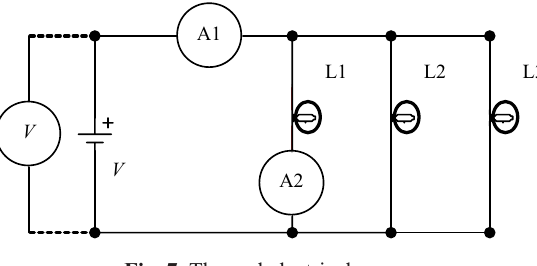
Fig. 7. The real electrical